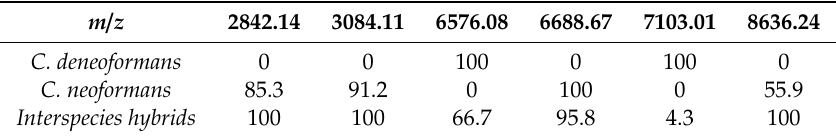
Table 3. Di ff erentiation of the analyzed Cryptococcus species based on the absence / presence of biomarker Table 3. Differentiation of the analyzed Cryptococcus species based on the absence/presence of peaks. Figures indicate the percentage (%) of isolates showing the indicated biomarker peaks. Figures indicate the percentage (%) of isolates showing the indicated peak.